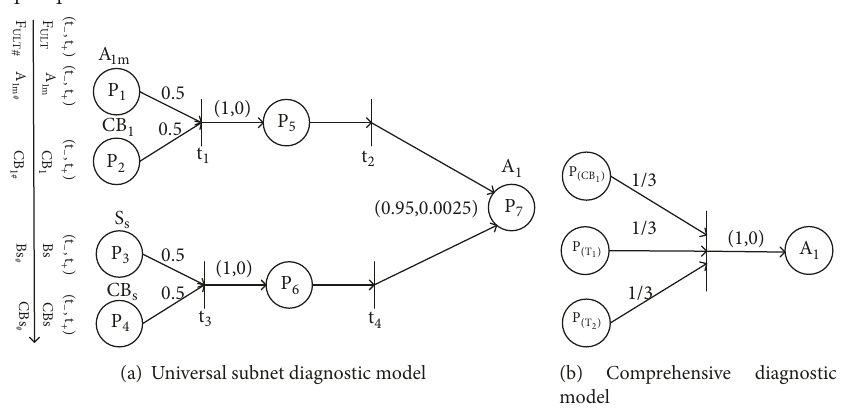
Figure 5: Single bus B 1 fault diagnosis model.